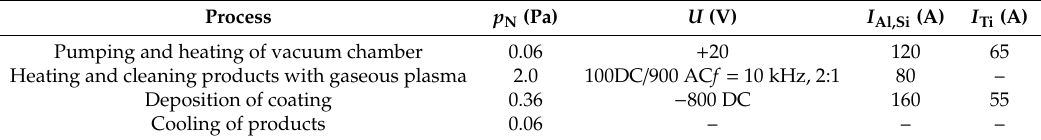
Table 1. Parameters of stages of the technological process of deposition of coatings. Process p N (Pa) U (V) I Al,Si (A) I Ti (A) Pumping and heating of vacuum chamber 0.06